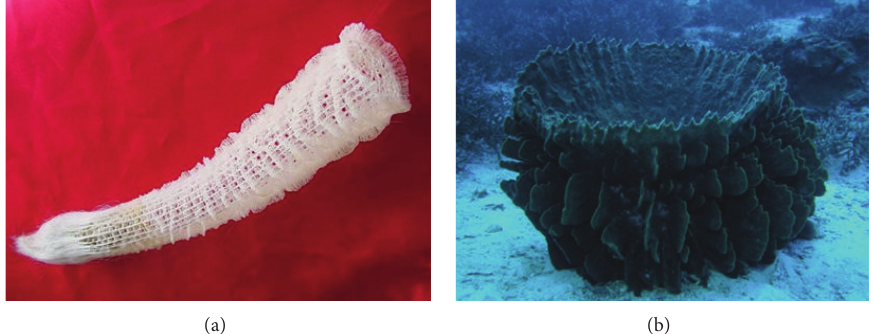
F 2: Siliceous sponges. (a) Venus’ Flower Basket ( Euplectella aspergillum ), greatest dimension 25cm (hexactinellid). Copyright Heidi Reed. (b) Barrel sponge ( Xestospongia testudinaria ),